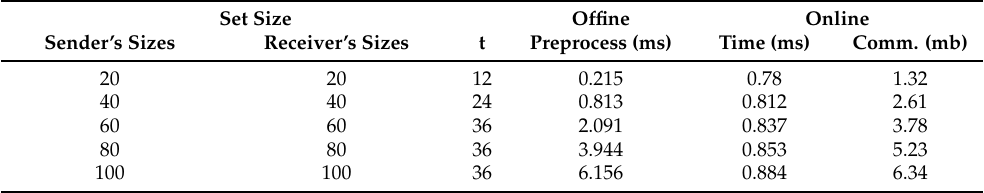
Table 3. The communication and time cost of STLPSI protocol with the same set size.